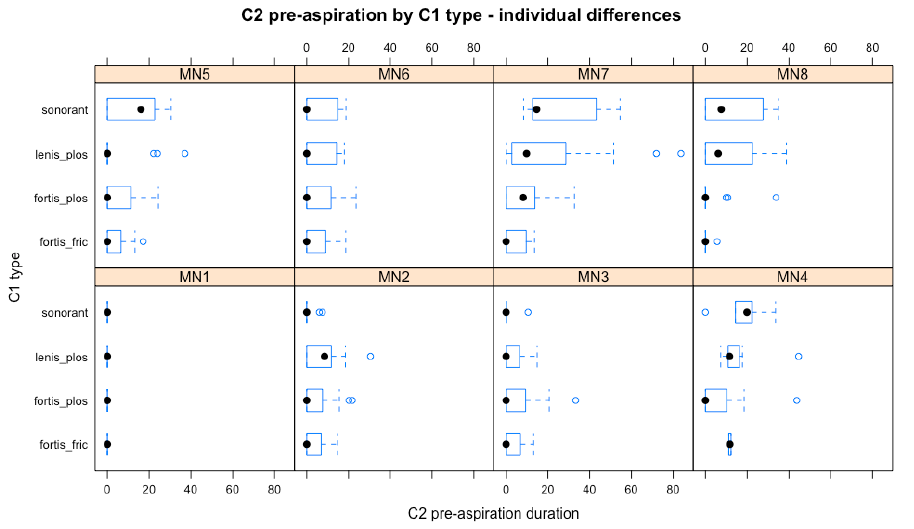
Figure 6: Effects of C₁ type on C₂ fortis plosive pre-aspiration duration by